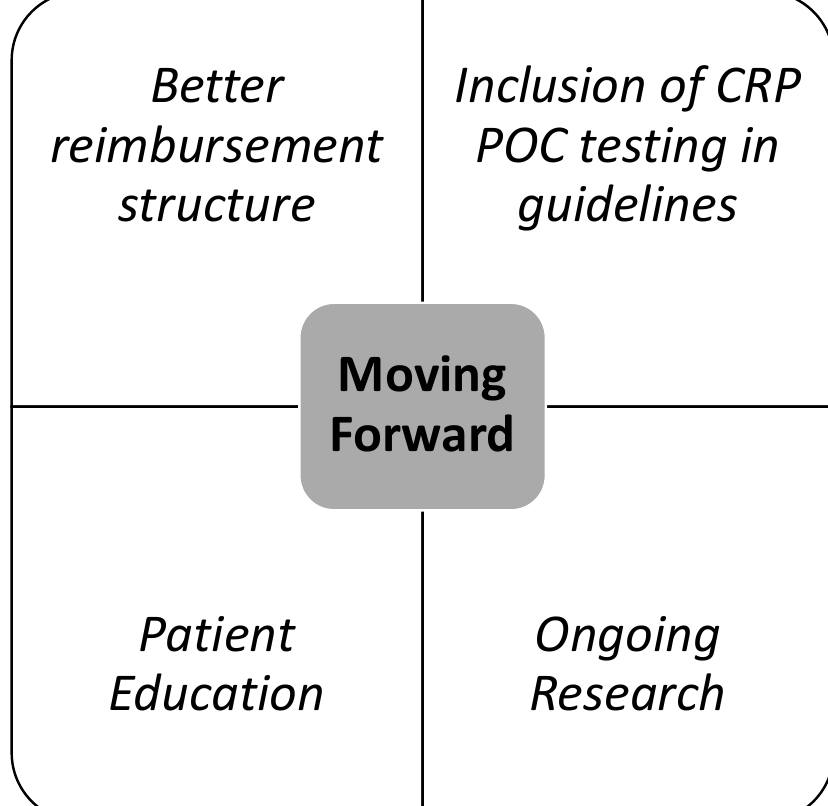
Figure 5. Key elements of reducing inappropriate antibiotic use moving forward.